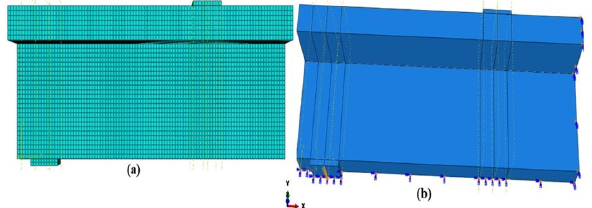
Figure 13: (a) The mesh; (b) Loading conditions of the composite beam